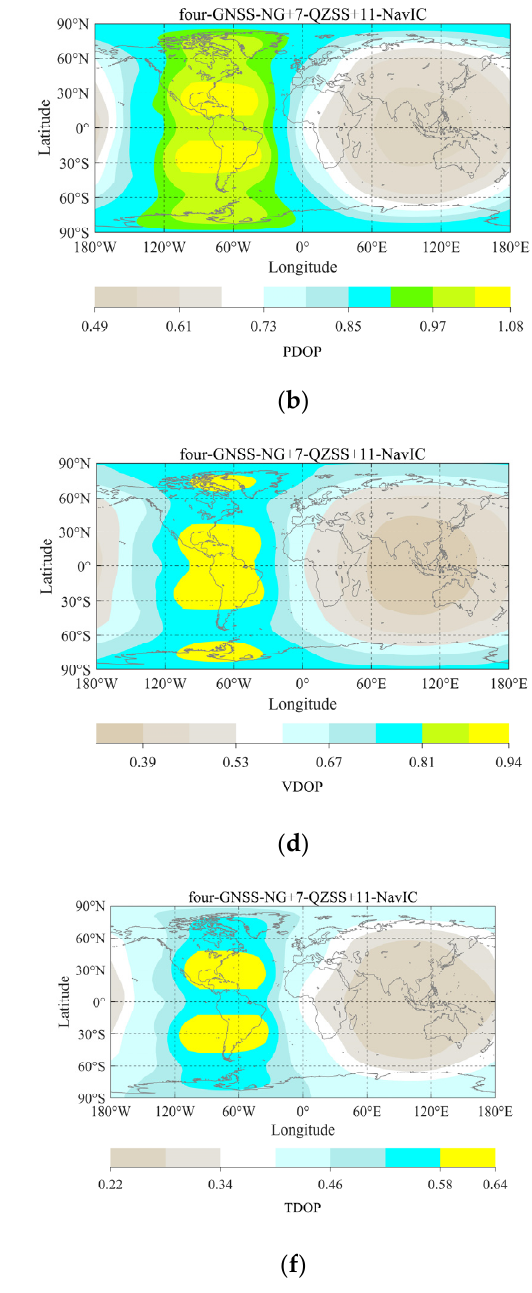
Figure 14. Satellite visibility and DOPs of the four-GNSS-NG+7-QZSS+11-NavIC: ( a ) visible satellites; ( b ) PDOP; ( c ) HDOP; ( d ) VDOP; ( e ) NDOP/EDOP; ( f ) TDOP. Table 8. Statistical results of satellite visibility, PDOP, HDOP, VDOP, and TDOP of the four-GNSS- NG+7-QZSS+11-NavIC.